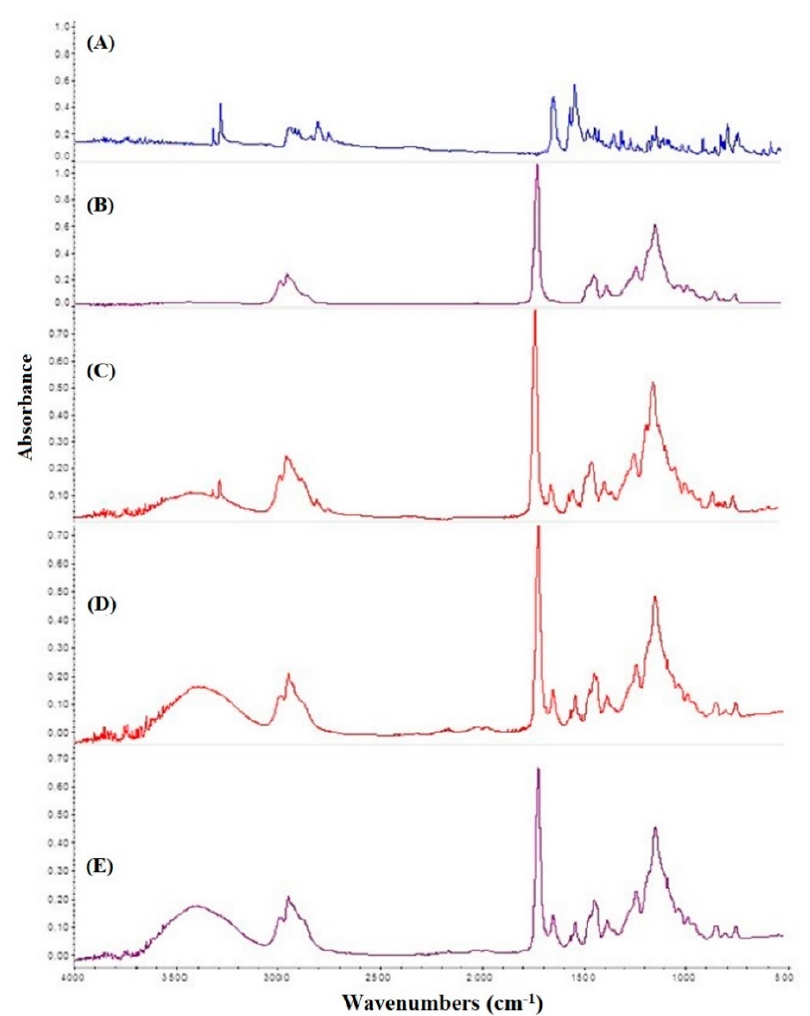
Figure 3. FTIR in ATR mode spectra of ( A ) pure CYT; ( B ) Eudragit ® RS100; ( C ) Eudragit+CYT physical mixture; ( D ) Eudragit+CYT blank spray-dried sample; ( E ) S-CYT-B spray-dried powder (reported as a representative example for all the prepared powders).